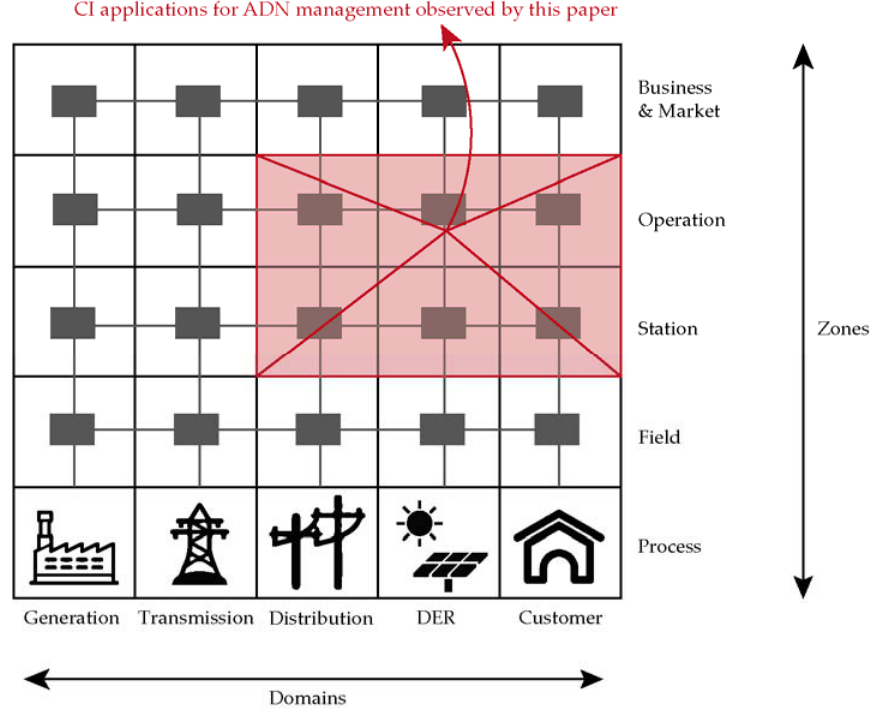
Figure 1. SGAM reference architecture with emphasis of CI applications observed by this